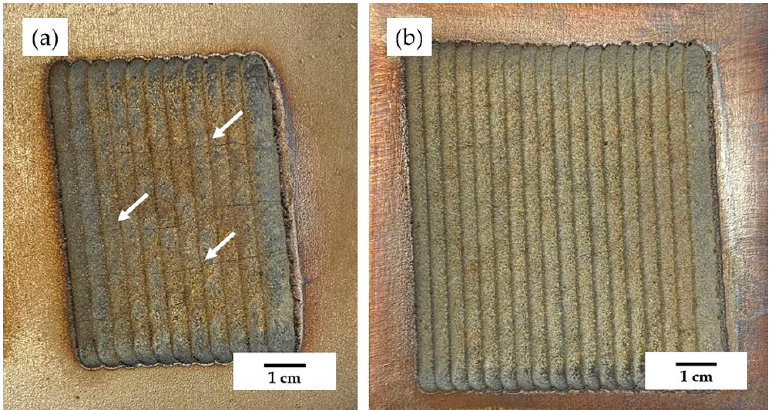
Figure 4. Surface topography of the coatings: ( a ) 55NiTi coating; ( b ) 55NiTi + 5Ni coating.